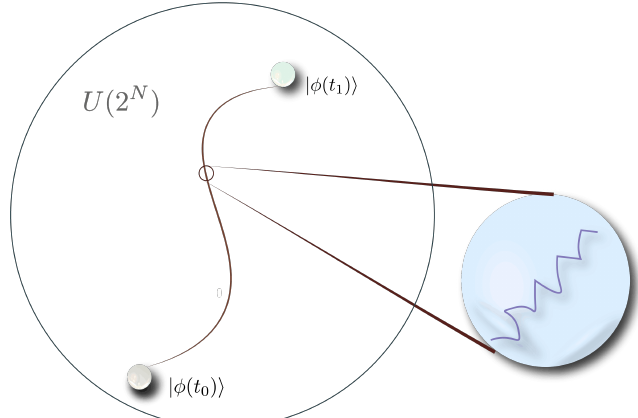
Figure 2. An evolving quantum state | φ (cid:105) from the reference | φ ( t 0 ) (cid:105) to some later state | φ ( t 1 ) (cid:105) on a unitary manifold U ( 2 N ) . The line depicts the minimal geodesic between the quantum state at the two instances, t 0 and t 1 . The distance between t 0 and t 1 corresponds to the relative state complexity, namely the computational cost associated with going from | φ ( t 1 ) (cid:105) to | φ ( t 0 ) (cid:105) (47). The zoomed-in region depicts the discrete evolution dictated at each step by the instantaneous Hamiltonian (30) and bounded by the penalty factors